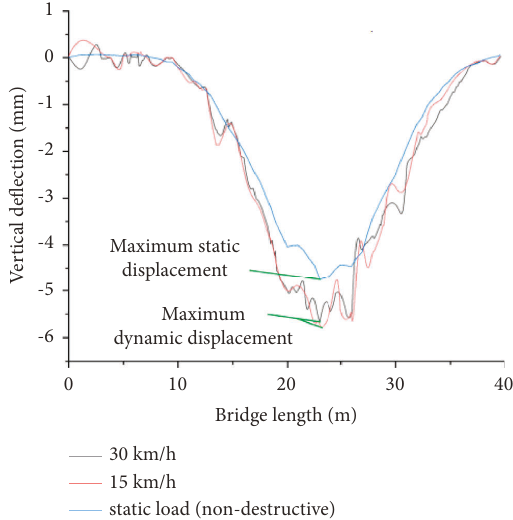
Figure 17: The bridge deflection curve.